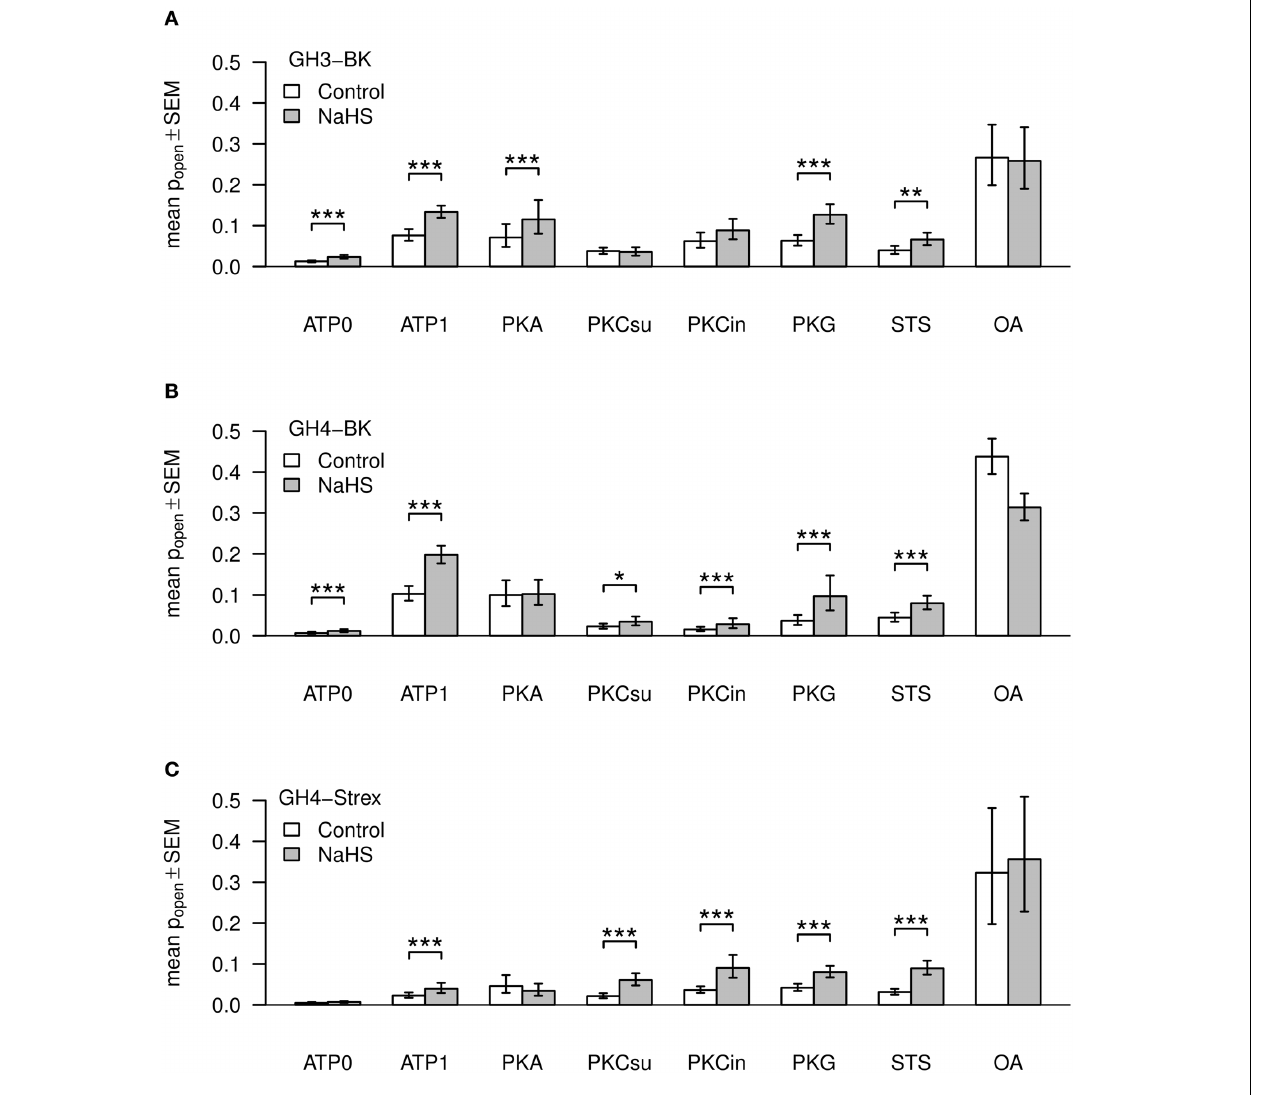
to the pipette solution; ATP0 – no ATP added; ATP1 – 1mM ATP added; PKA (50 units); PKCsu (0.1 units/ml); PKCin – 500nM; STS – 1 μ M; OA – 100nM. Figures are based on back transformed means and s.e.m. values (error bars), respectively. Asteriks indicate significance of H 2 S (300 μ M NaHS equivalent to effective 34–41 μ M H 2 S) effects according to the logit transformed data.